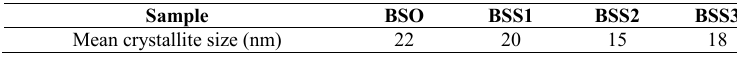
Table 2. Mean crystallite size of different thin